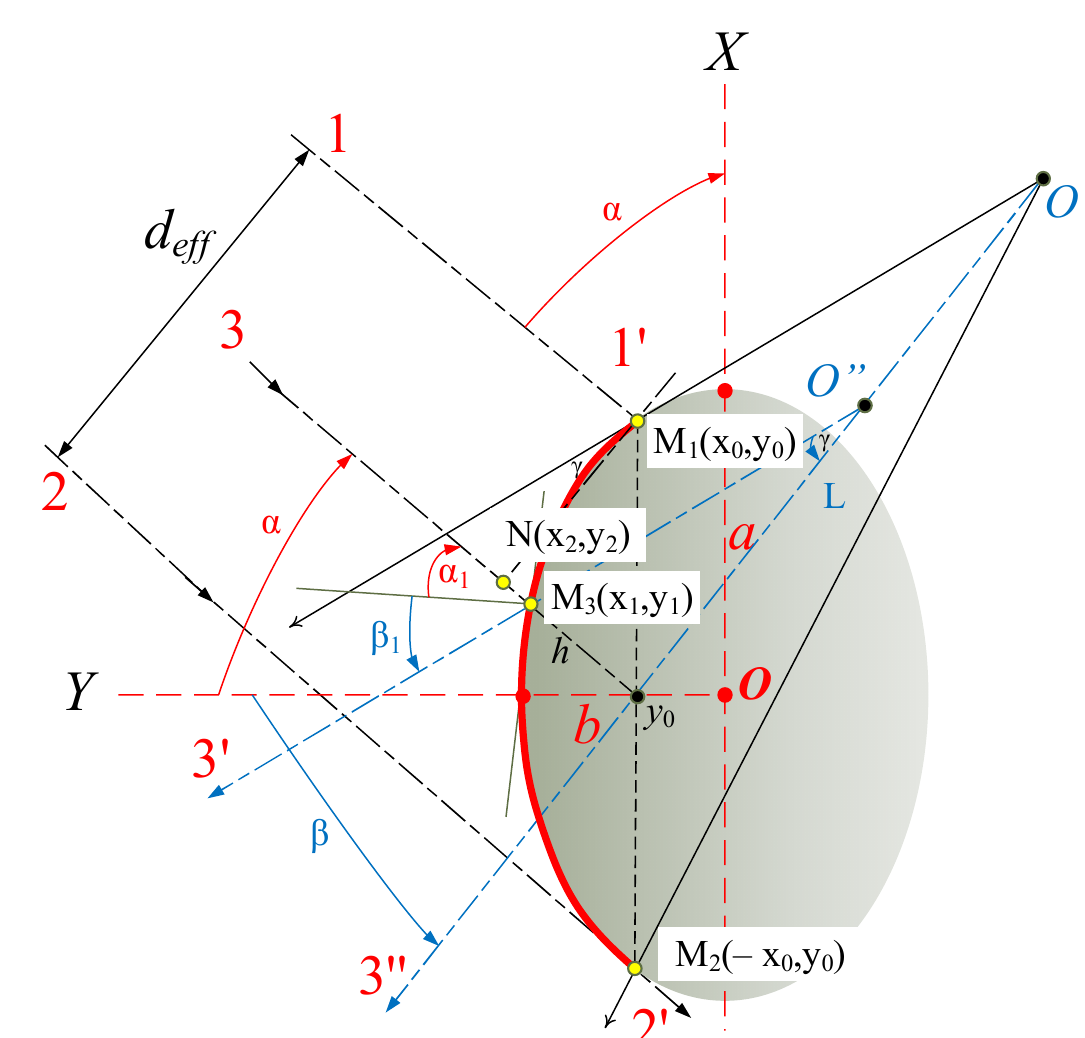
Figure 6. Construction of the effective angular width of the reflected beam for the first case of orientation of the seed relative to the recording window 3 on Figure 2. The ellipse M 1 M 2 is defined by semi-axes a = l s The tangent equation at the point M 1 ( x 0 , y 0 )